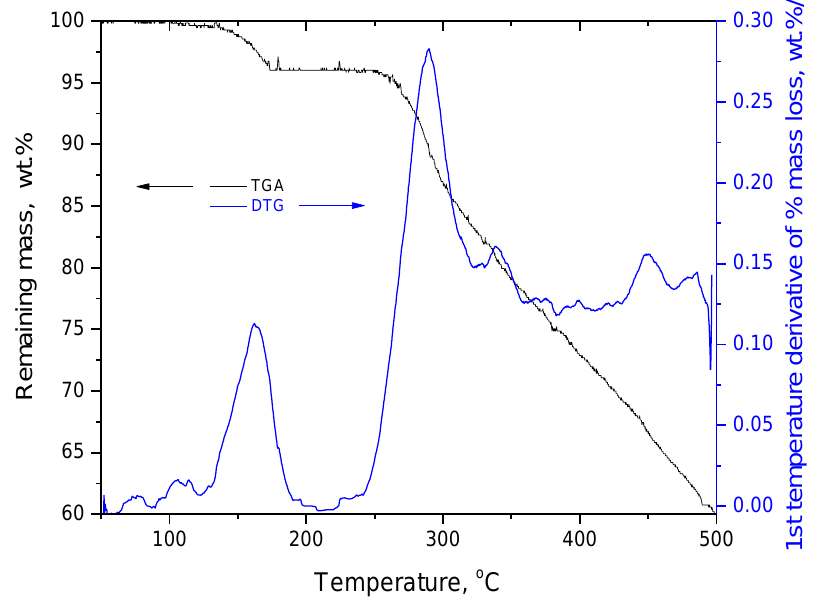
Figure 1. TGA and DTG (first temperature derivative of % mass loss) curves of silybin in the tem- temperature range 50–500 ◦ perature range 50–500 °C.